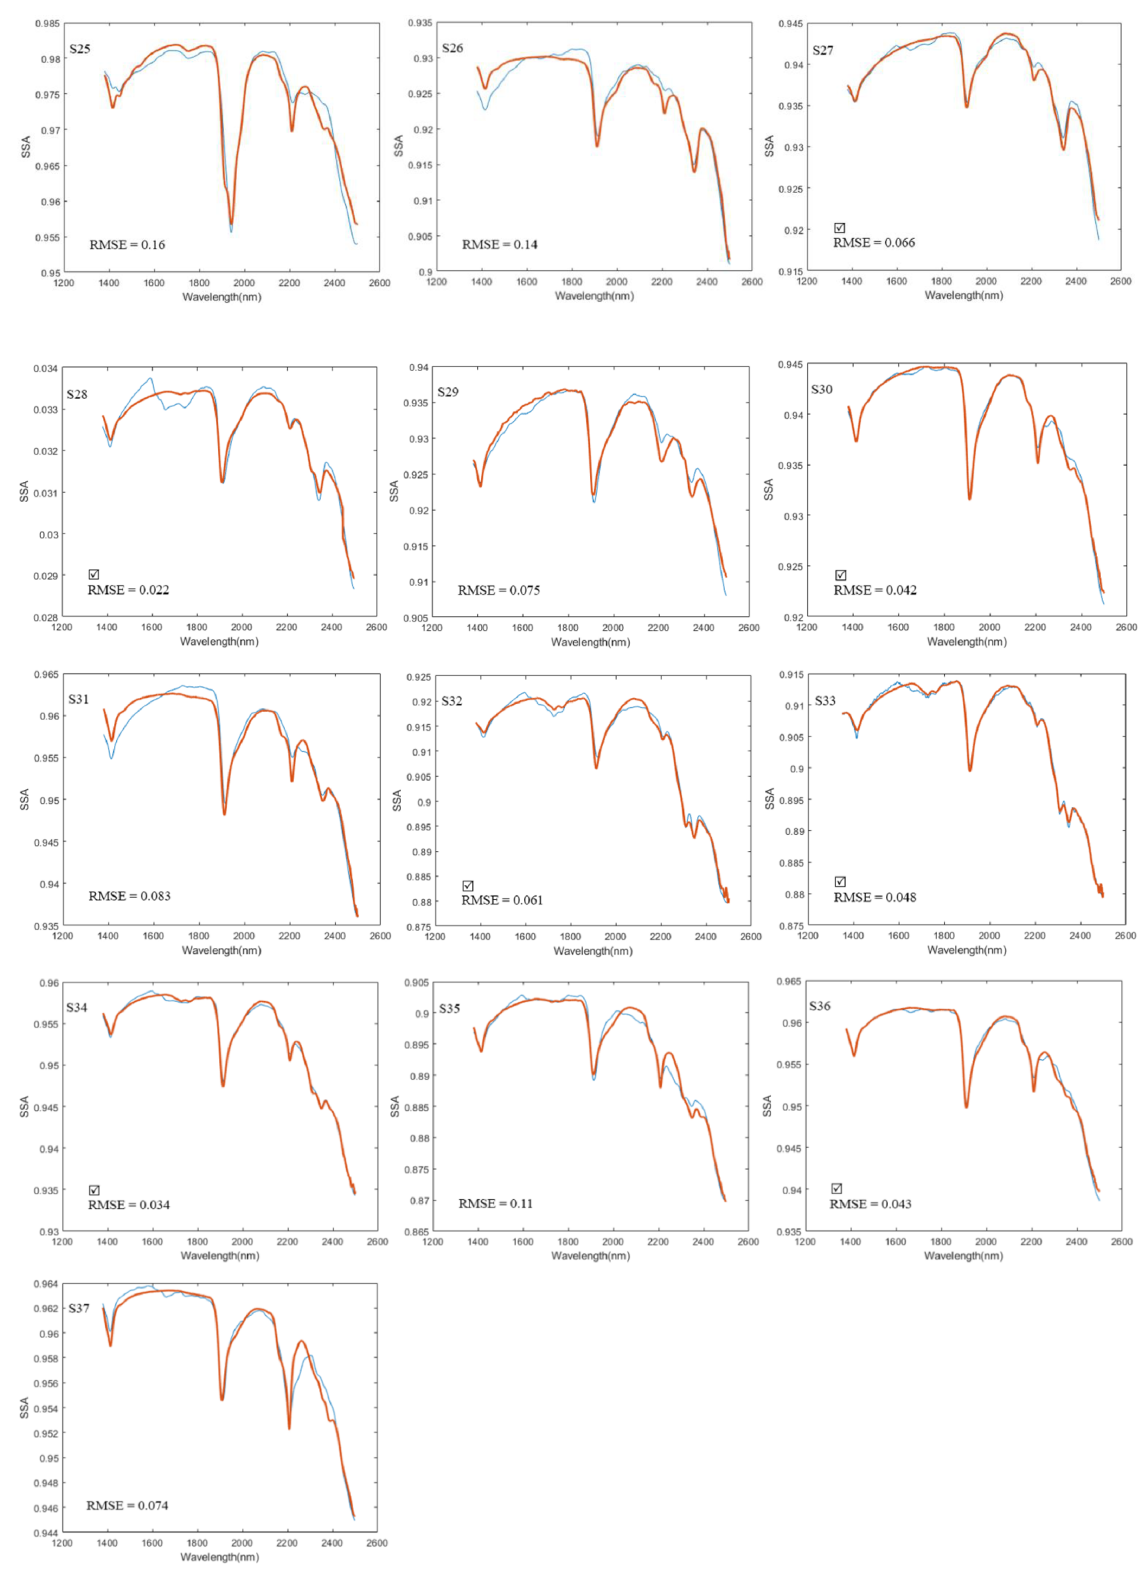
Figure C1. Spectral model fit (red line) and RMSE are shown for all 37 dust sample SSA spectra (blue line). Check marks represent that the model fits relatively well based on visual inspection and relatively low